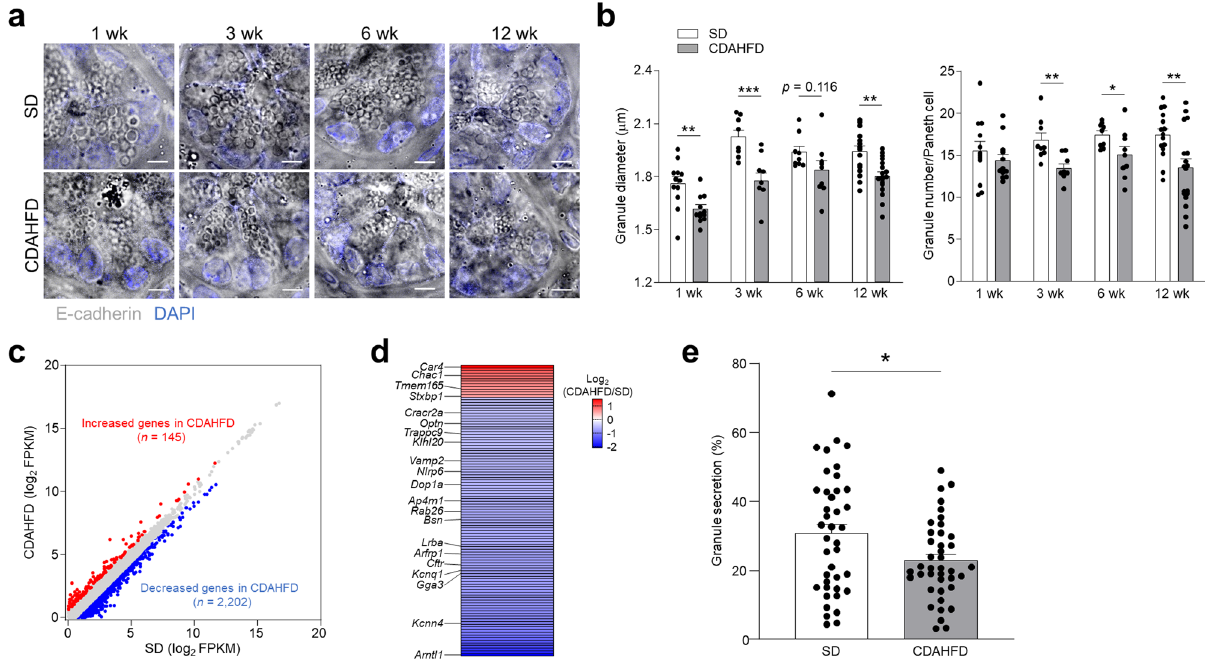
Figure 3. Paneth cell granule secretion is impaired in the CDAHFD group. ( a ) Representative images of whole mount small intestine obtained with confocal microscopy. Scale bar: 5 μm. ( b ) Granule diameter and granule number of each Paneth cell per field. Data are shown as mean ± SEM for n = 9–18 fields/group and quantified based on at least 3 fields per mouse. Each group contains 3–6 mice. ( c , d ) Paneth cells isolated from small intestine of mice fed with SD and CDAHFD for 3 wk were analyzed by RNA-seq. Paneth cells are pooled from 6 mice/group and data show the average of two independent experiments. ( c ) Scatterplot of global gene expression profiles of SD and CDAHFD group derived from RNA-seq analysis. ( d ) Heatmap showing log 2 fold change of differentially expressed genes (1.5-fold increase or decrease) associated with Paneth cell functions in the CDAHFD group compared with SD group. ( e ) Enteroids derived from the small intestine of SD and CDAHFD groups were stimulated by 1 μM CCh for 10 min. Percent granule secretion was calculated as percent area granule secretion. Data are shown as mean ± SEM for n = 40 crypts/group. Each group contains 4 mice. * P < 0.05, ** P < 0.01 and *** P < 0.001, by unpaired two-tailed Student’s t